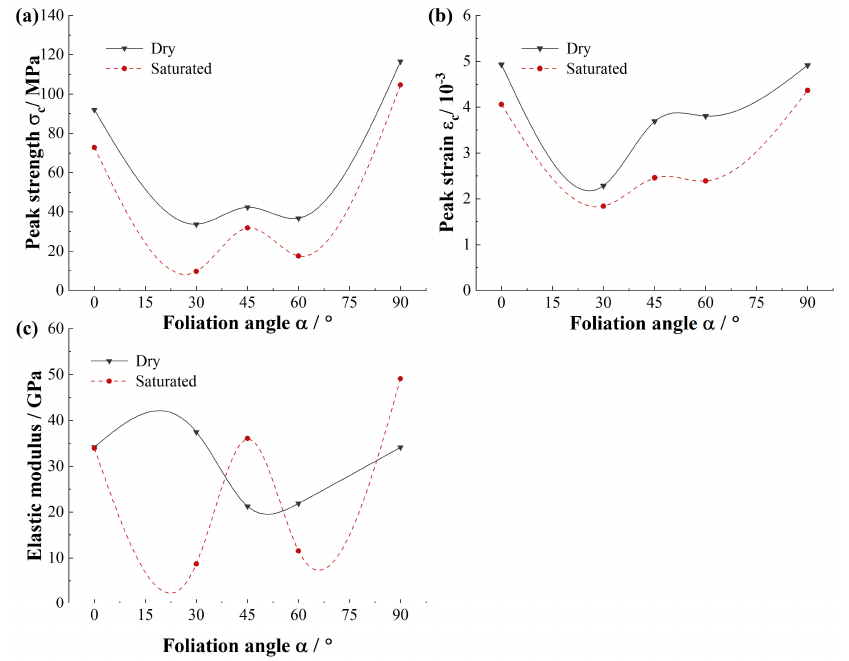
Figure 4. Comparison of mechanical properties of foliated phyllite from dry condition and water-saturated condition: ( a ) Uniaxial compression strength, σ c ; ( b ) Peak axial strain, ε c ; ( c ) Elastic modulus, E .